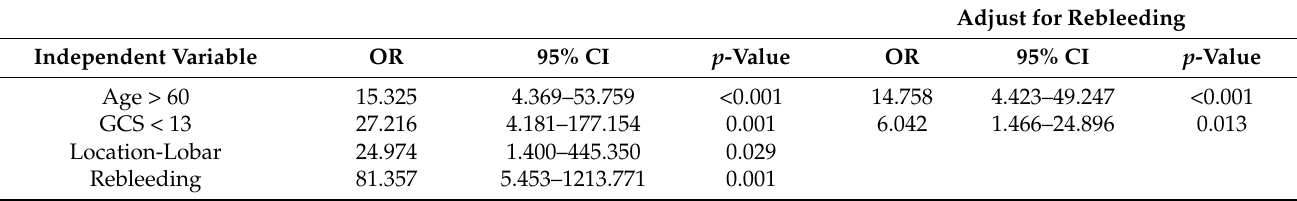
Table 5. Multivariate analysis of poor outcome 1 year after discharge.